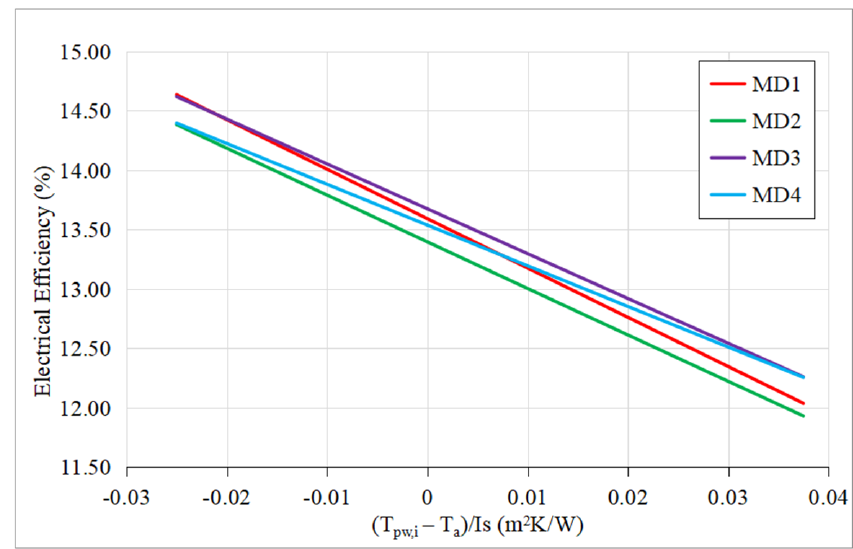
Figure 15. Thermal efficiency of four PV/T module models.